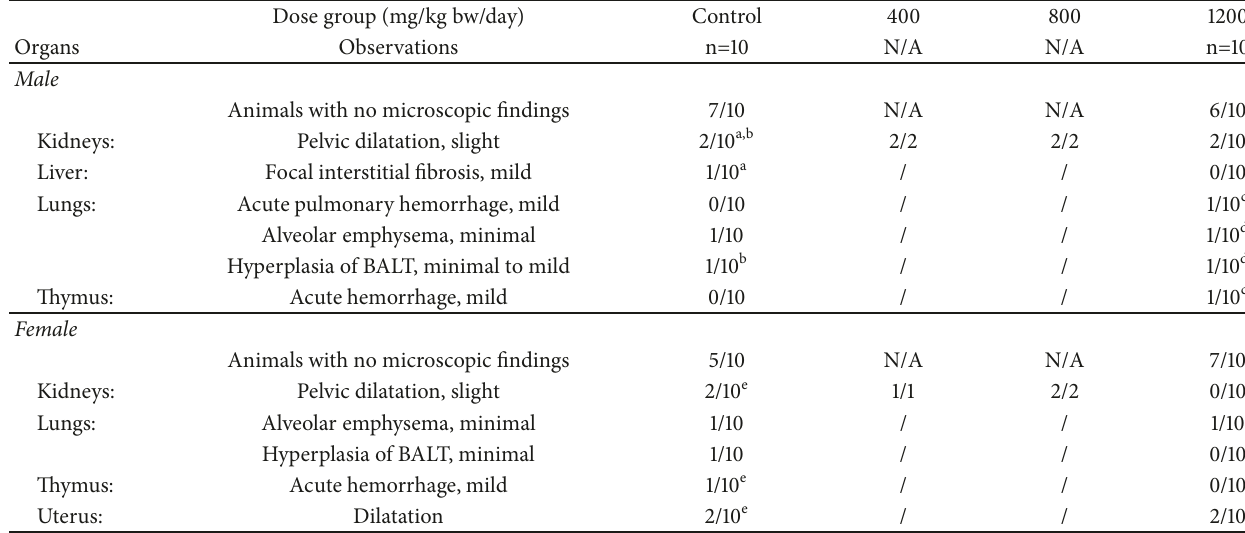
Table 6: Summary of histopathology